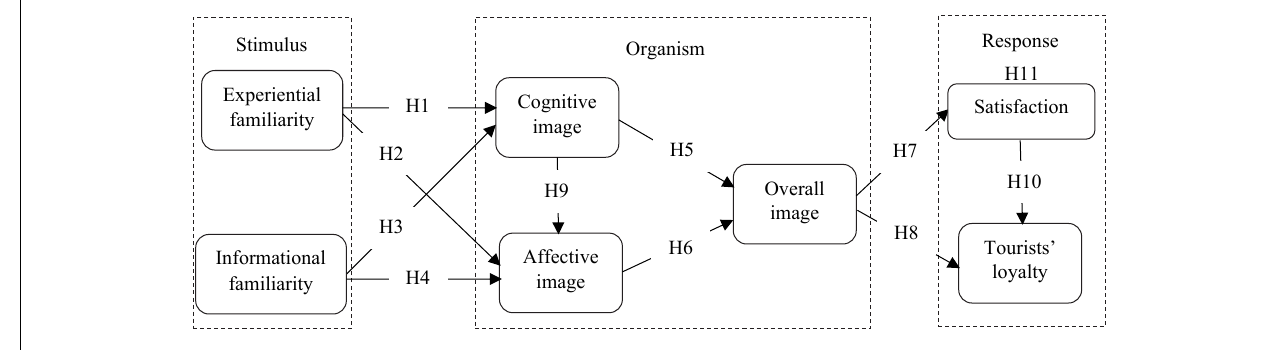
FIGURE 1 | Conceptual research